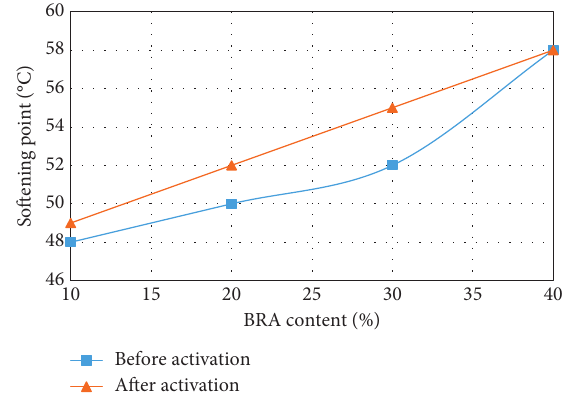
Figure 3: Softening point of BRA-modified asphalt before and after activation.